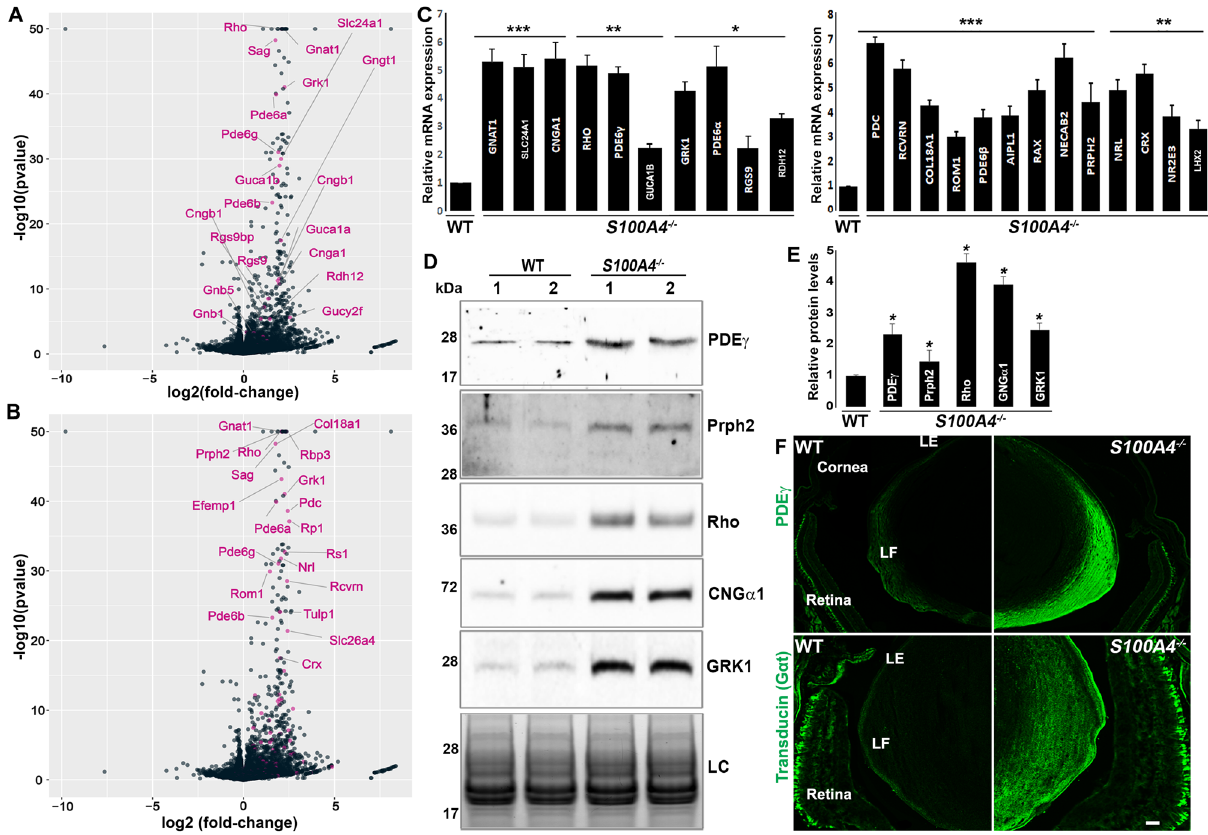
Figure 5. Aberrant induction of photoreceptor and retina-specific genes in S100A4 −/− mouse lenses. ( A , B ) Volcano plots highlighting the upregulation of selected photoreceptor and retinal genes in S100A4 −/− lenses (labeled in pink), identified based on gene set enrichment by curated pathways and GO terms, respectively. ( C ) qRT-PCR confirmation of significant upregulation of the indicated photoreceptor and retina specific genes in S100A4 −/− mouse lenses relative to littermate WT lenses (***P < 0.001, **P < 0.01 and *P < 0.05, based on Student’s t test and an n = 4 pooled samples consisting of 6–10 lenses each). ( D , E ) Immunoblotting based confirmation of increased levels of selected photoreceptor specific proteins in S100A4 −/− lens lysates (100,000 g pellet) compared to WT lenses. Lanes 1, 2 represent two biological replicates. LC loading control (lens insoluble fractions resolved by SDS–PAGE, stained with Gelcode blue, and staining intensity of the indicated protein band used for normalization). *P < 0.05, based on Student’s t test and n = 4. ( F ) Representative images (from three biological replicates) from immunofluorescence based confirmation of upregulation of PDEγ and transducin